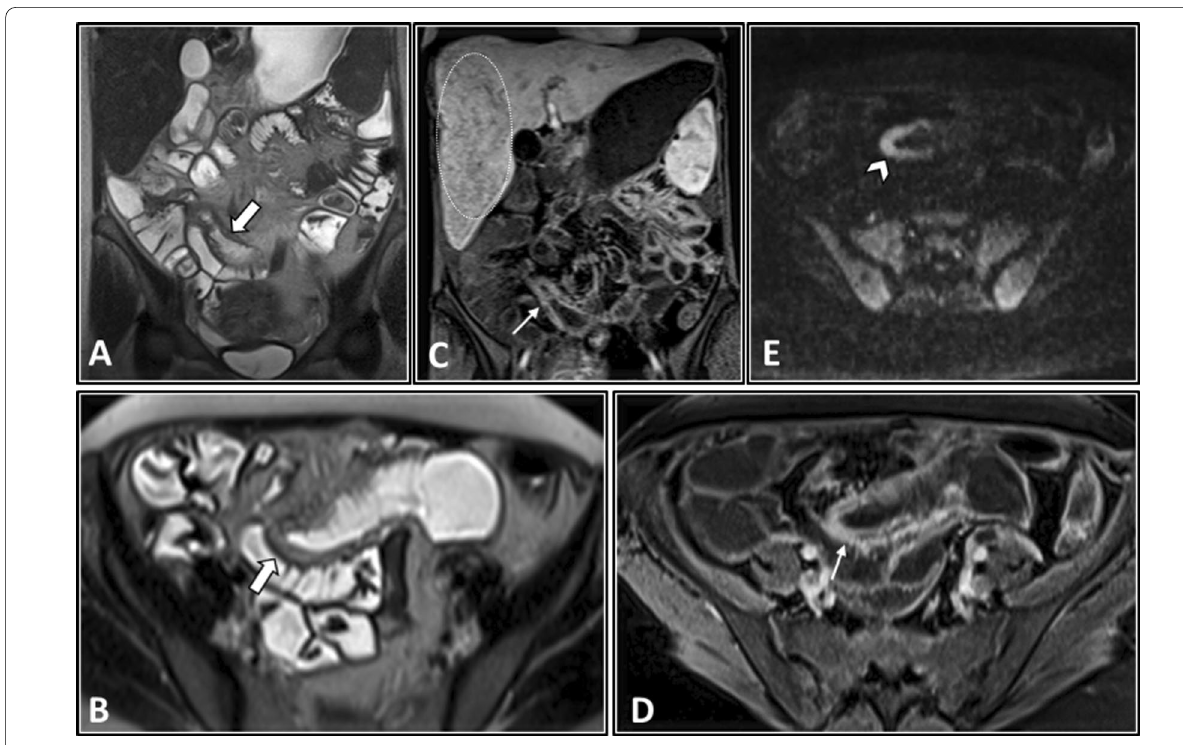
Fig. 4 Intestinal vasculitis in a 32-year-old female with PAN (polyarteritis nodosa) presenting with episodic abdominal pain, fever, anemia, and elevated liver enzymes and inflammatory markers. MRE was obtained. Coronal and axial T2-W images ( A , B ) show a single thickened segment of mid ileum (thick white arrows) with mild T2 hyperintensity more likely secondary to submucosal edema. This is associated with mild degree of upstream bowel distention. Coronal and axial post-contrast T1-W images ( C , D ) display mural hyperenhancement (thin white arrows) with a relatively striated pattern. DWI at a b-value of 800 s/mm 2 ( E ) shows restricted diffusion (white arrowhead), suggesting increased inflammatory cell density. The patient underwent double-balloon enteroscopy following this MRE, but it was complicated by bowel perforation at this segment. Then, surgical resection and ileostomy were performed. Histopathological assessment of resected segment revealed vasculitis consistent with polyarteritis nodosa (PAN). Heterogeneous enhancement of liver at arterial phase is also depicted (C), which raises suspicion for microvascular involvement (white dotted